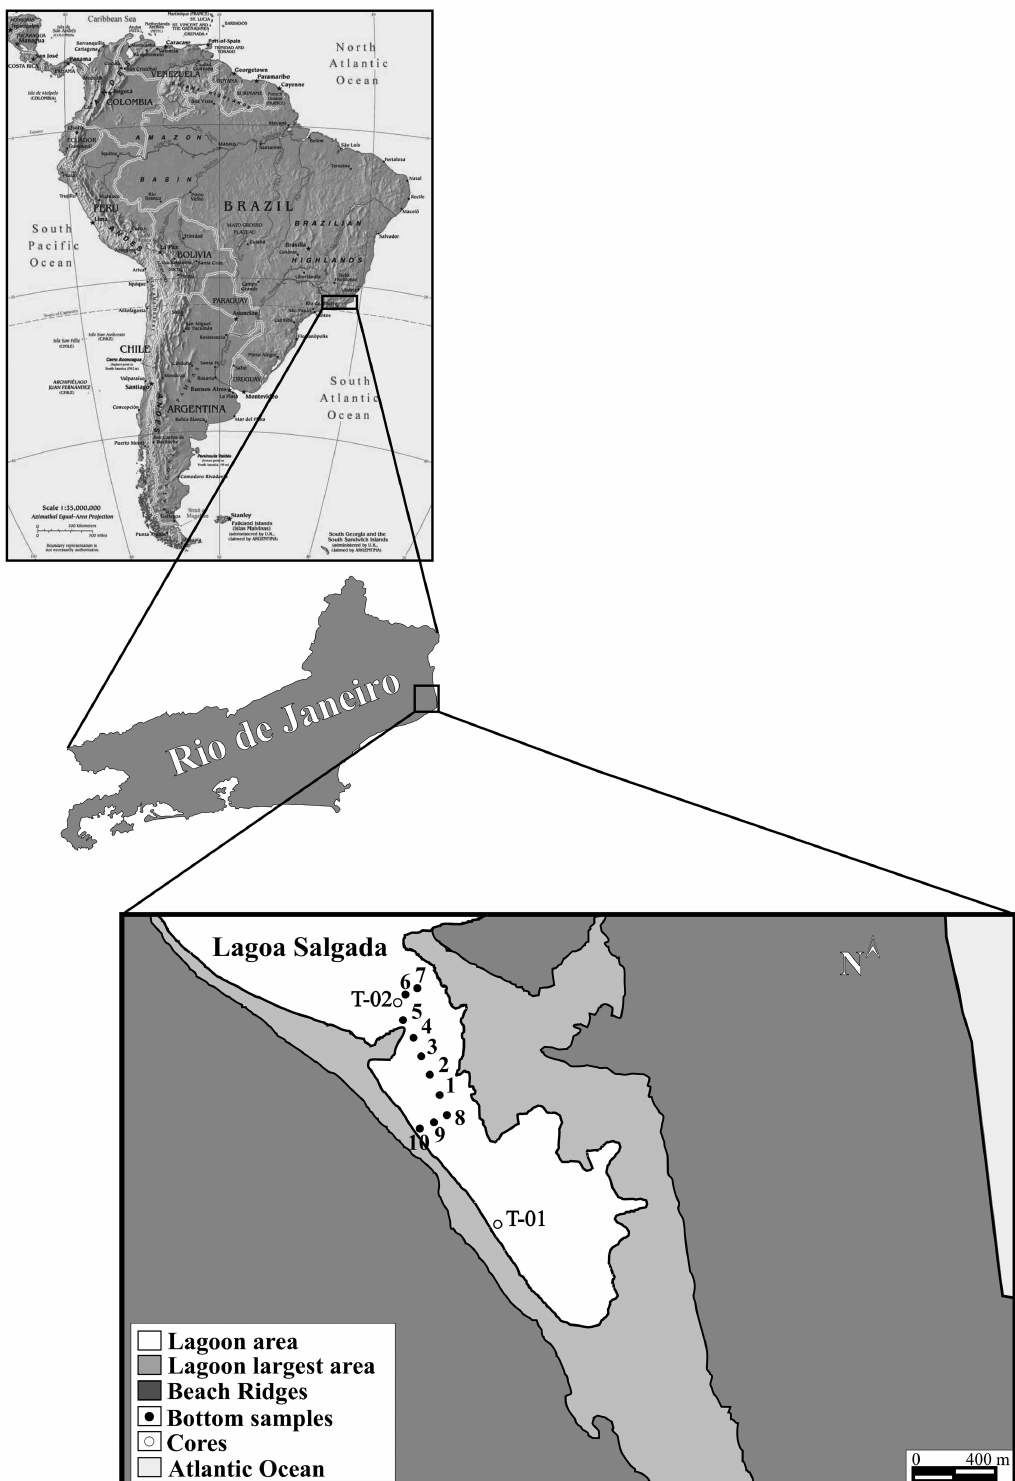
Fig. 1 – Map of the study area, showing the location of Lagoa Salgada in the northeastern Rio de Janeiro State. The inset shows a portion of the lagoon with the sample location (surface and